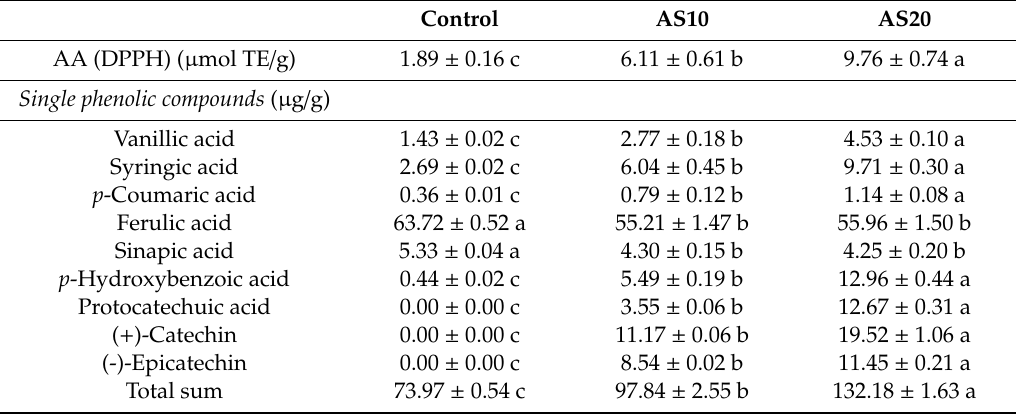
Table 8. Phenolic compounds and antioxidant activity of biscuits enriched by increasing levels of almond skins. Control = biscuits without almond skins; AS10 and AS20 = biscuits prepared by adding 10 g and 20 g almond skin powder per 100 g of wheat flour,